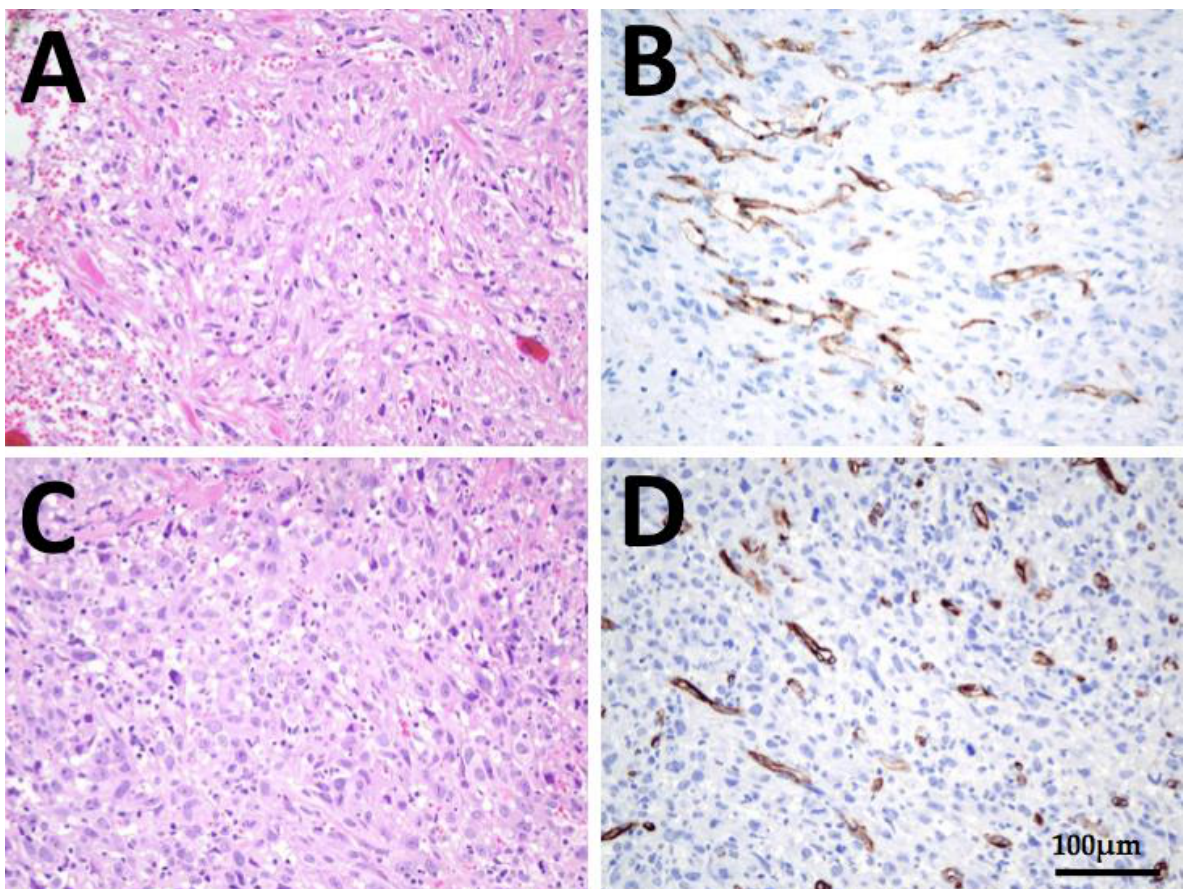
Figure 2. Immunohistochemistry of patient 1: ( A , B ), histology of ATC thyroidal primary tumor and ( C , D ) tumor infiltration of the soft tissue surrounding the thyroid gland in HE staining and PSMA immunohistochemistry, respectively. Strong immunoreactivity of more than 5% of neovasculature in the tumor can be seen at both localizations (PSMA labelling-index 2). Scale bar, 100 µm, respectively.